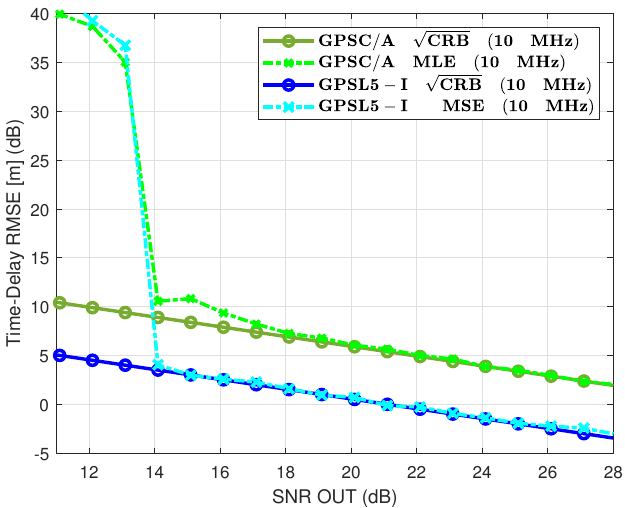
Figure 5. CRB/MLE for GPS L1 C/A BPSK(1) and GPS L5-I BPSK(10).